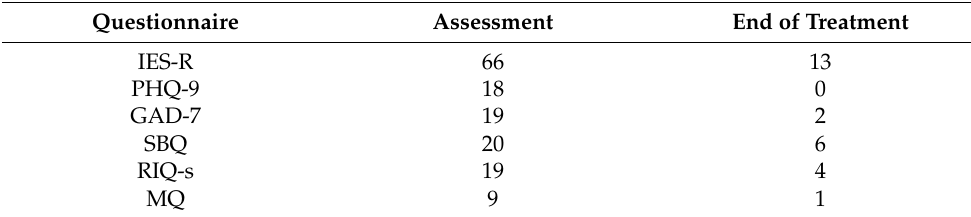
Figure 1. Scores on the Impact of Events Scale-Revised over the course of therapy. At the end of therapy, Daniel scored 0 on the PHQ-9 (below clinical cut-off) and 2 on the GAD-7 (below clinical cut-off). His scores on the RIQ-s, SBQ, and MQ also reduced (Table 1). Table 1. Questionnaire scores at assessment and end of